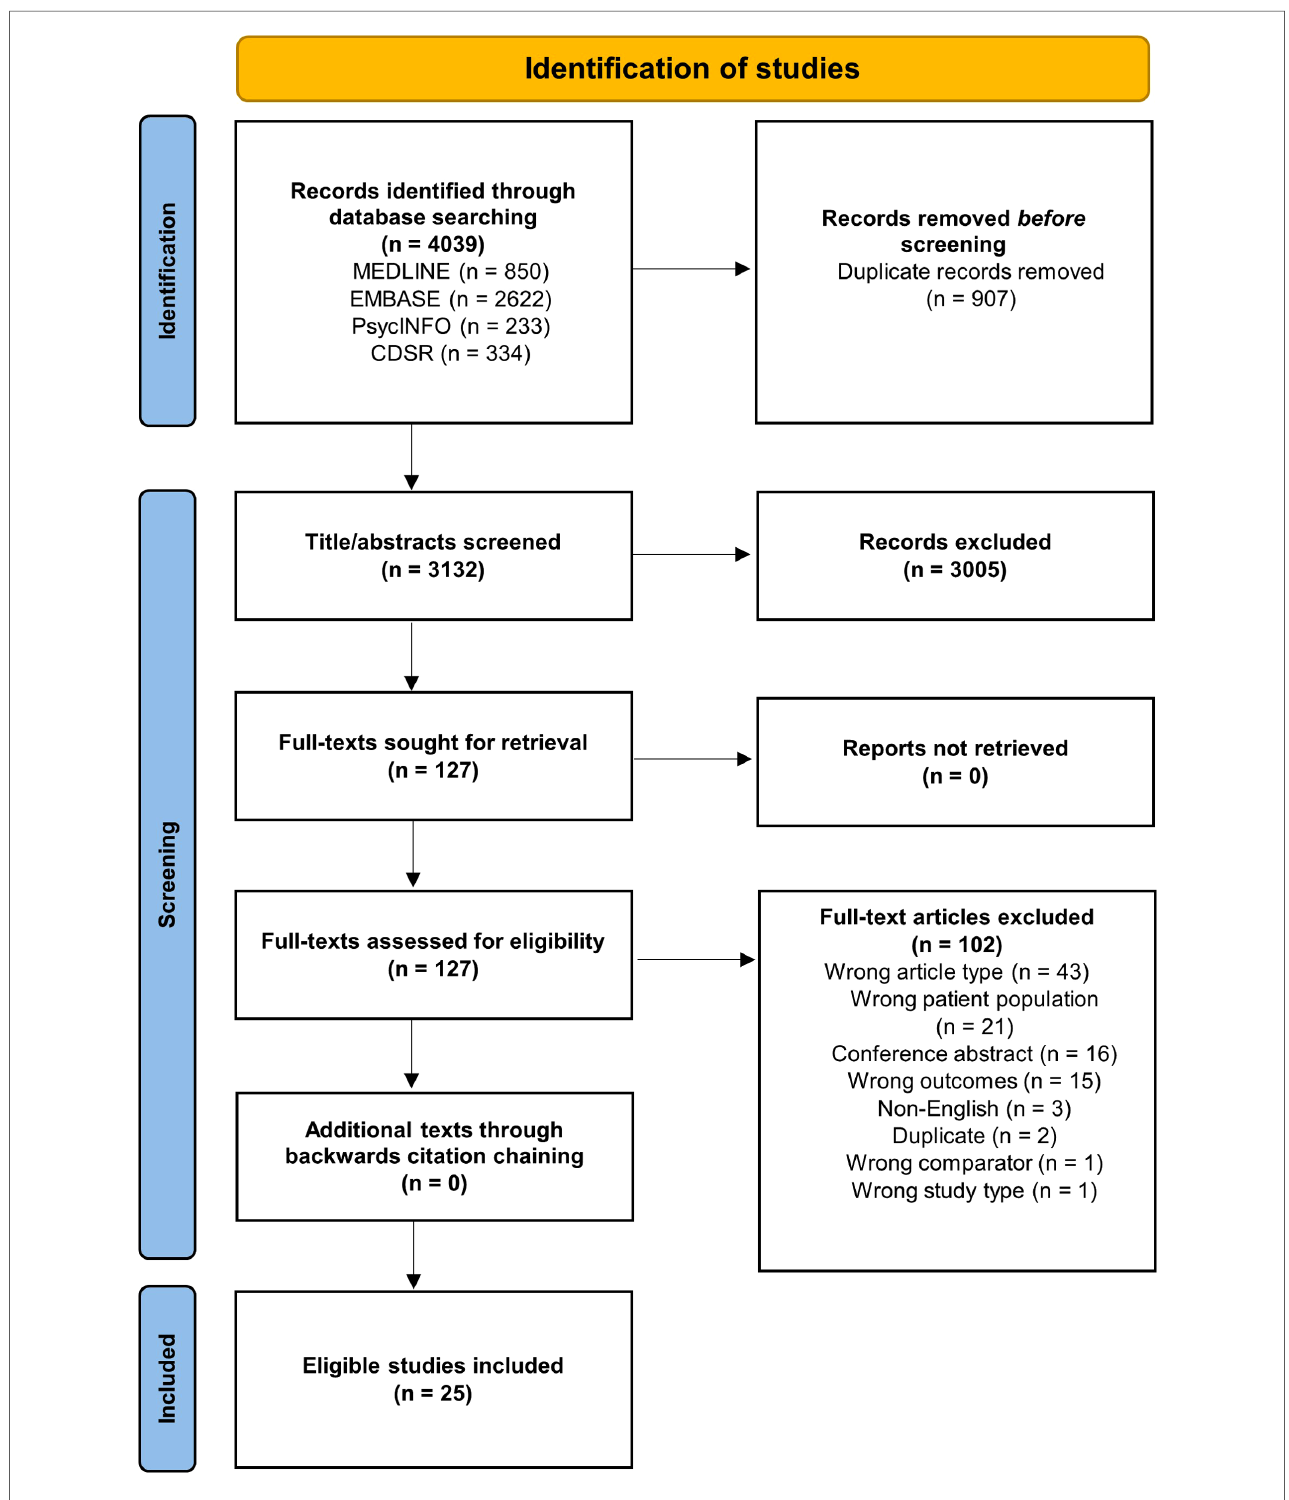
FIGURE 1 Study selection fl